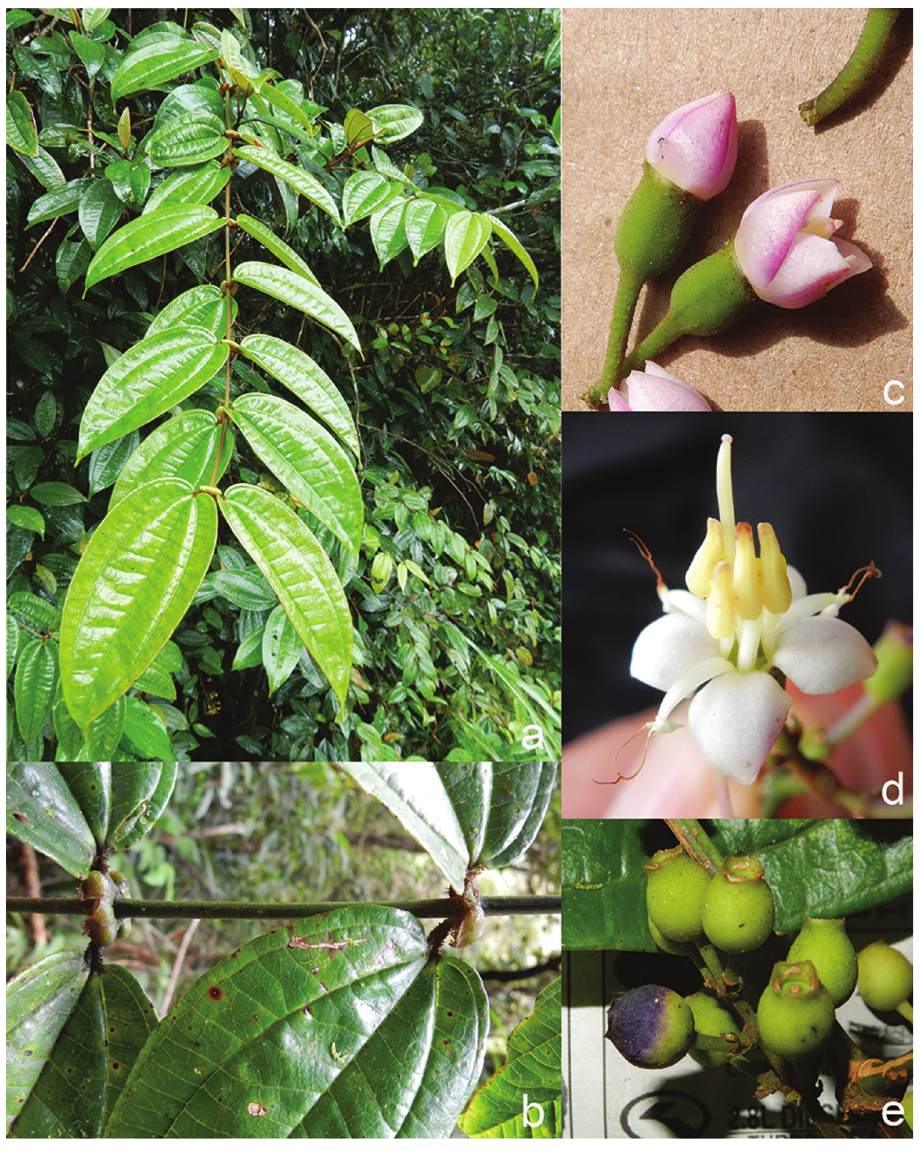
Figure 14. Dissochaeta glabra var. glabra a habit b branchlet c hypanthium d flower e fruits. Photo- graphs by D. Penneys; vouchers: Penneys 2446 (WNC), Penneys 2474 (WNC) & Penneys 2487 (WNC). 3–4 × 3–3.5 mm, reflexed, white purplish or purple, base clawed, apex acute.